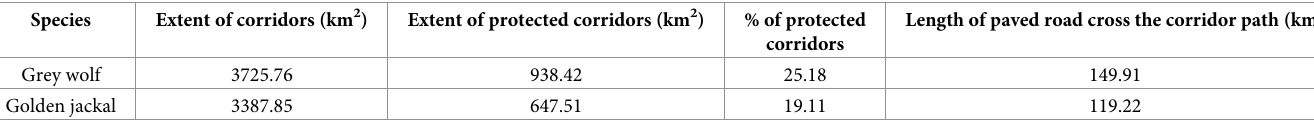
Table 3. The extent and percent of corridors covered by current conservation networks for golden jackal and grey wolf in Central Iran. The median value of habitat suitability for presence points was used as threshold to define the highly suitable habitats.